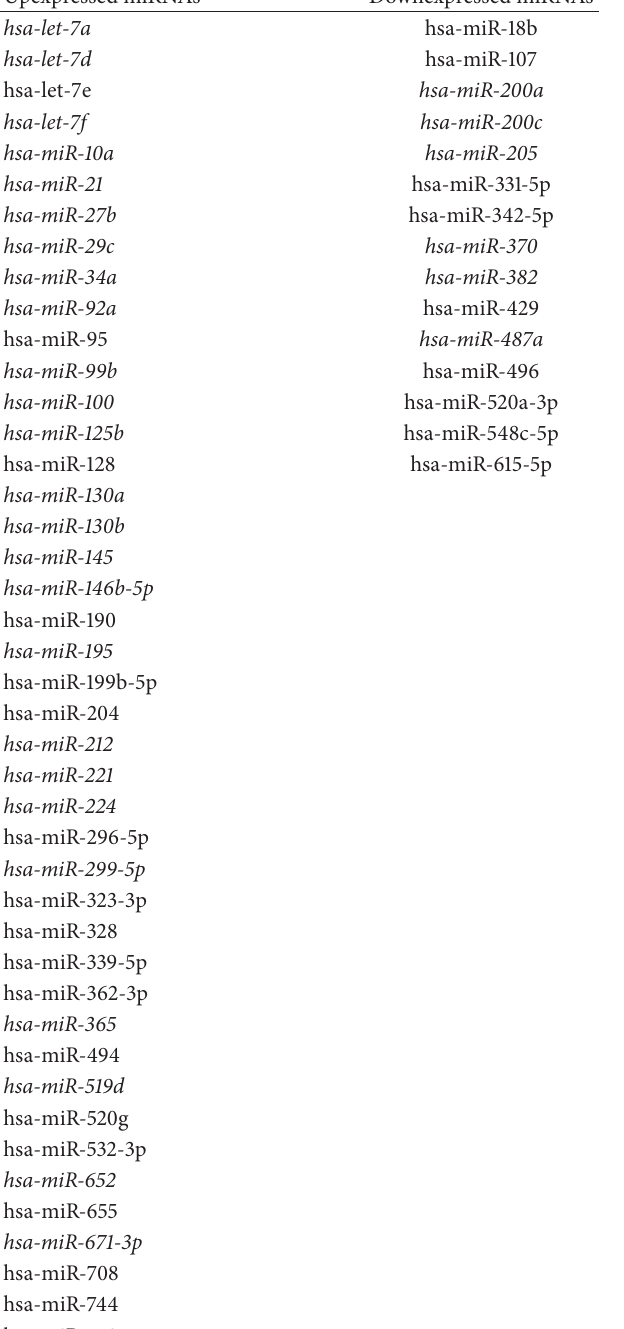
Table 2: Differently expressed miRNAs at T0 in obese patients versus normal-weight subjects.